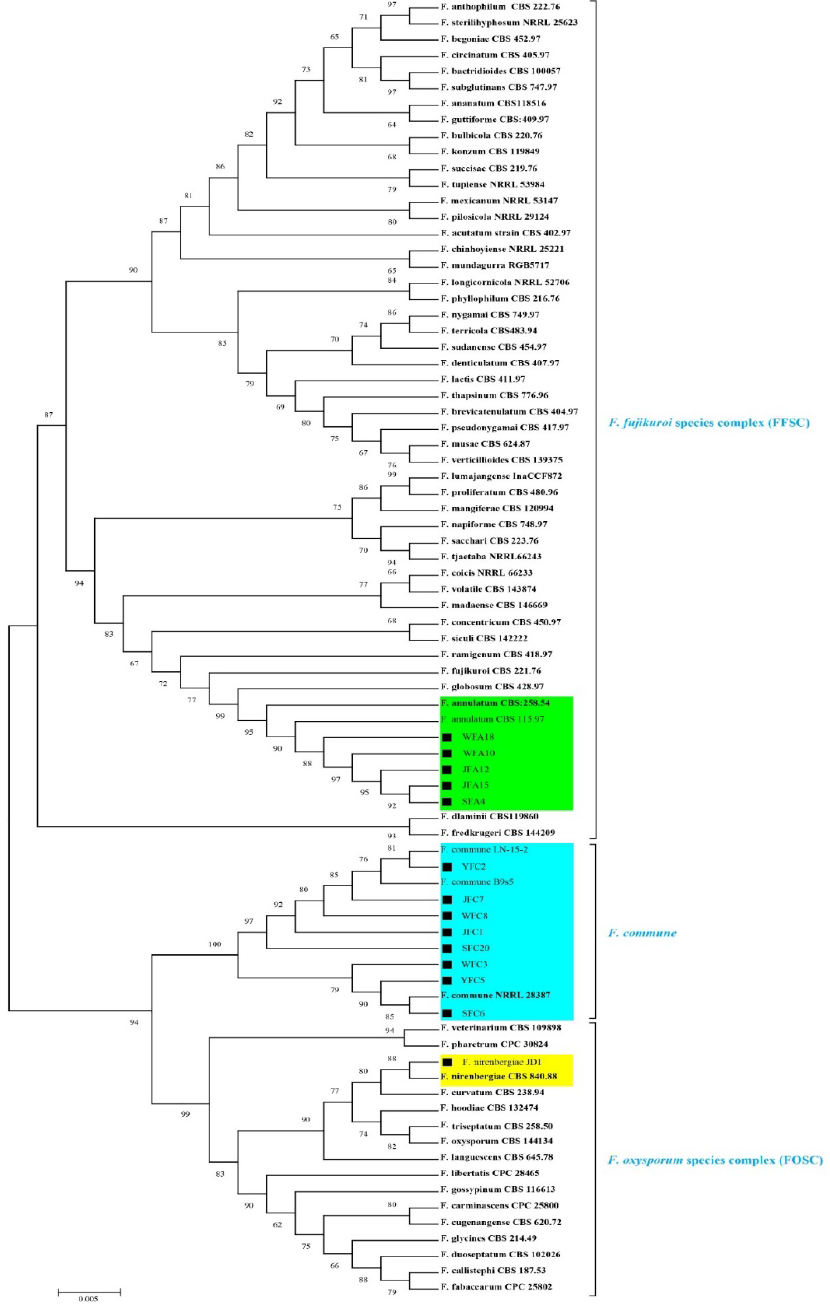
Figure 3. Phylogenetic tree generated from maximum likelihood analysis of combined rpb2 and tef1 sequences, depicting the phylogenetic relationships of Fusarium species causing corm rot disease in Crocus sativus from China. Isolates recovered from saffron during the current study are indicated by a black square ( (cid:4) ). Clades including isolates obtained from saffron are shaded in color. Ex-type, neotype, and epitype strains are indicated in bold. Support values representing bootstrap percentages are shown on the branches.